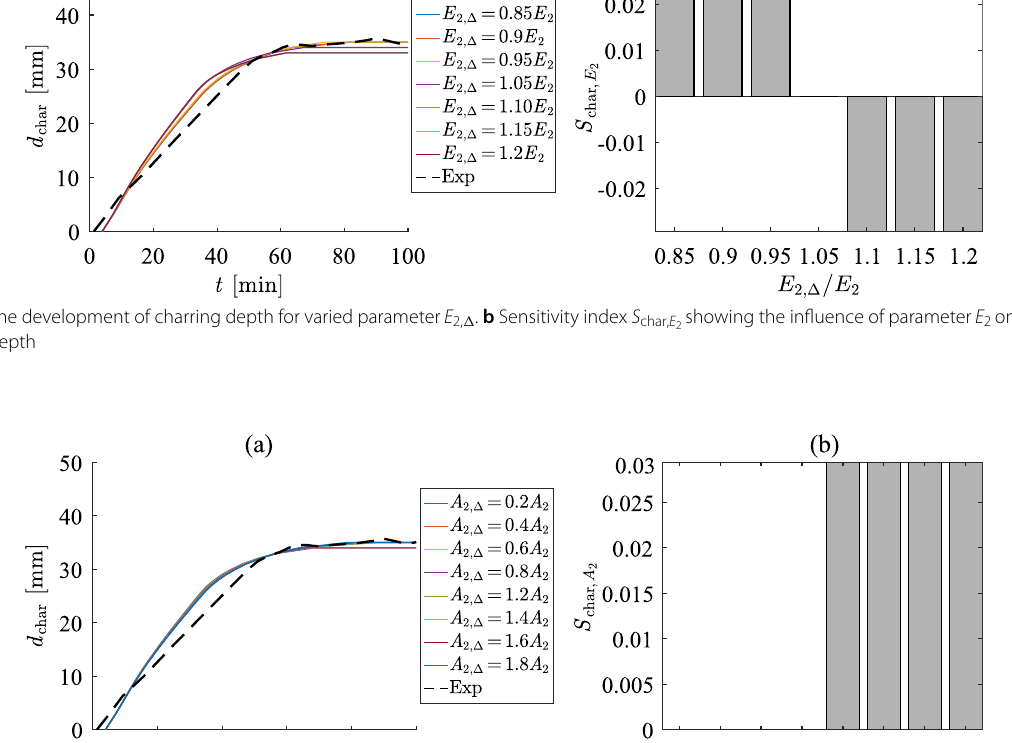
showing the influence of parameter A 2 on the 2